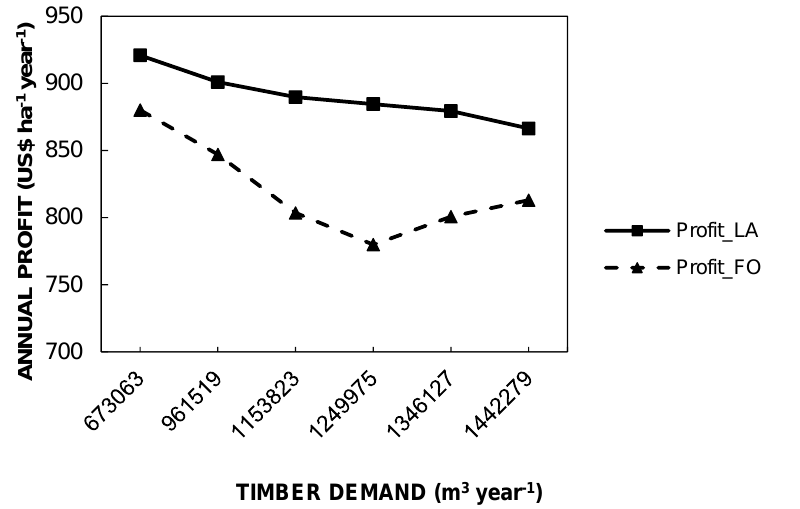
Figure 5. Household profits achieved by the landscape approach and the current forest approach.